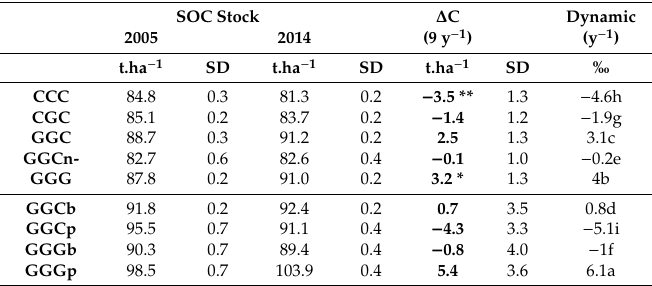
Table 4. Predicted carbon stocks and their evolution in the whole soil profiles under di ff erent grassland management. SD is standard deviation, * is statistical significances of storage’s Z-score (shown in Figure 3, * p -value is < 0.05, ** p -value is < 0.01) and a lowercase letter is statistical significance from